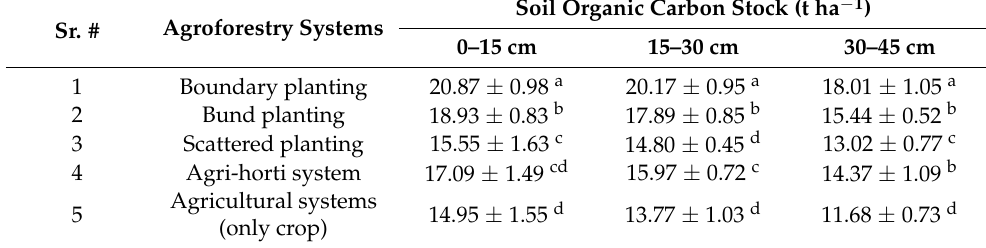
Table 5. Soil organic carbon stocks of different agroforestry systems at various depths in the semi-arid region.